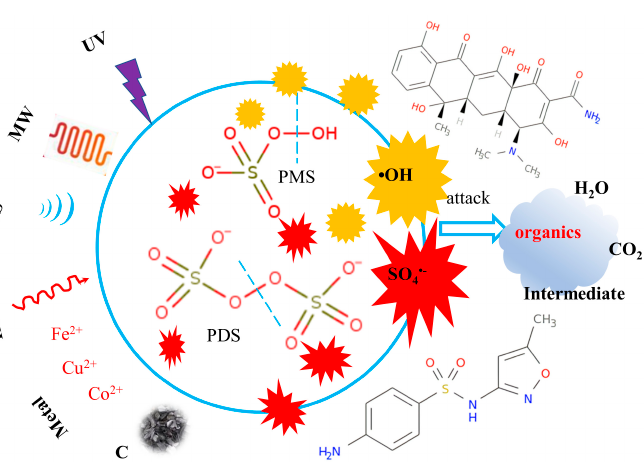
Figure 1. Various activation methods for PDS and PMS.